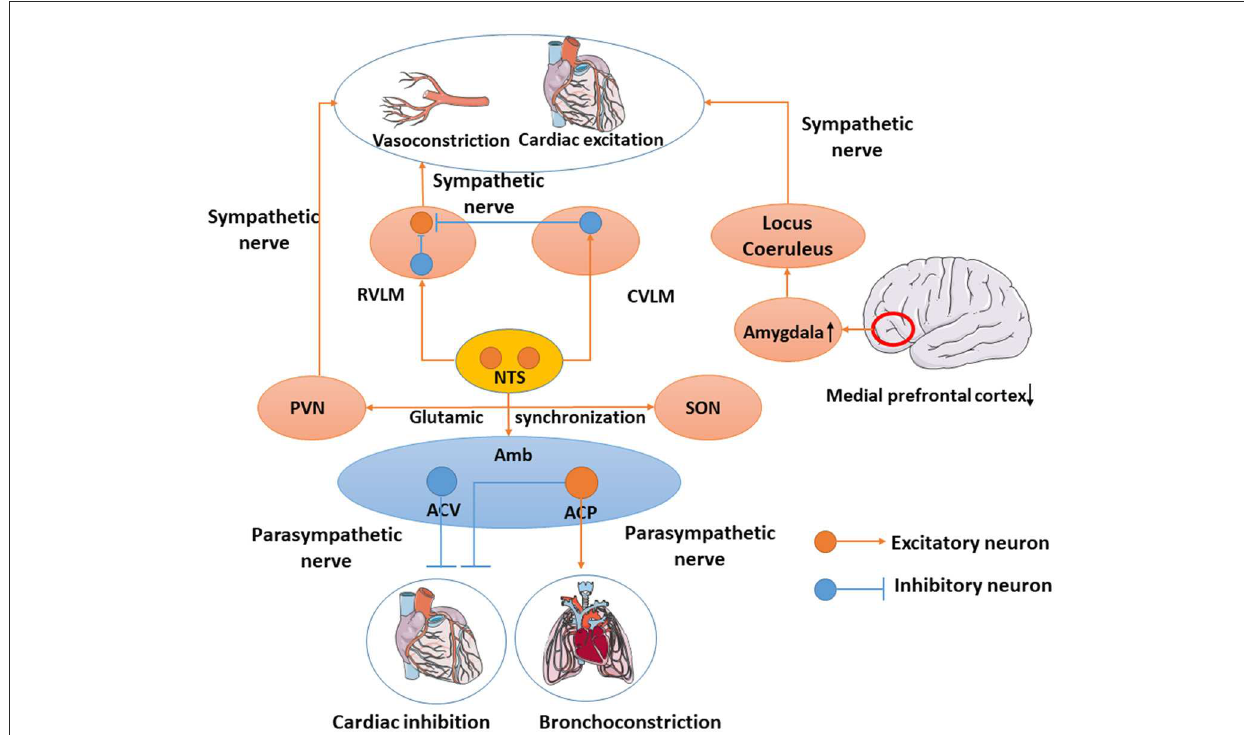
FIGURE1 Cardiovascular-related neural network. Amb includes ACV and ACP. ACV will sense changes in peripheral blood pressure and regulate cardiovascular function, whereas ACP induces bronchoconstriction simultaneously. NTS will project an excitatory projection onto the Amb to activate the vagus nerve and inhibit cardiovascular activity. NTS also activates CVLM and RVLM. In the meantime, CVLM would inhibit RVLM to inhibit vasoconstriction and cardiovascular excitation. Overactivation of the amygdala leads to the continued activation of the noradrenaline-producing locus coeruleus and chronic activation of the sympathetic nervous system. PVN regulates the sympathetic nerve and SON synchronizes with PVN through the glutamic acid circuits.